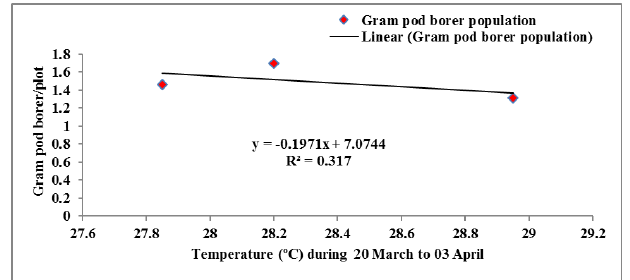
Figure 3: Relationship between the population of gram pod borer and temperature There was a positive correlation (R 2 = 0.031) between the population of gram pod borer and relative humidity. It indicates that the population of gram pod borer was increased with increasing relative humidity. A linear regression was fitted between relative humidity and population of gram pod borer (Figure 4). The regression equation y = a + bx, where y = population of gram pod borer, a = 0.779, b = 0.008 and x = relative humidity. The contribution of the regression (R² = 0.031) was 3.1%.